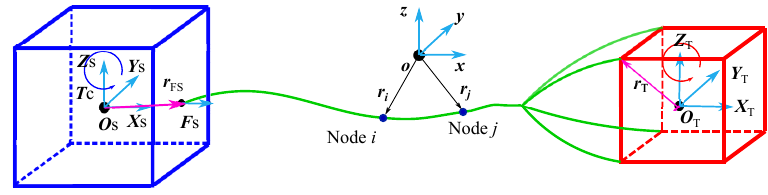
Figure 9. Concept of the ANCF model for sub-tether